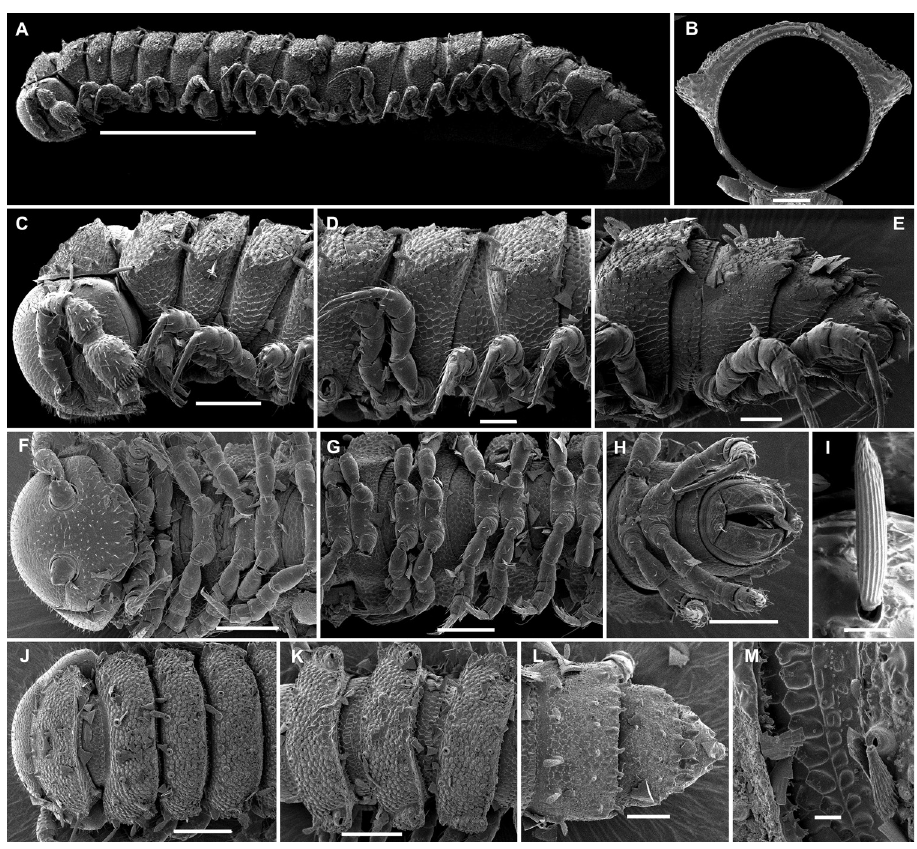
Figure 13. Hemisphaeroparia parva sp. n., SEM micrographs of ♂ paratype A habitus, lateral view B midbody segment, caudal view C, F, J anterior part of body, lateral, ventral and dorsal views, respec- tively D, G, K midbody segments, lateral, ventral and dorsal views, respectively E, H, L posterior part of body, lateral, ventral and dorsal views, respectively I tergal seta, lateral view M tergal fine structure. Scale bars: 0.5 mm ( A ), 0.1 mm ( C, F–H, J, K ), 0.05 mm ( B, D, E, L ), 0.01 mm ( I, M